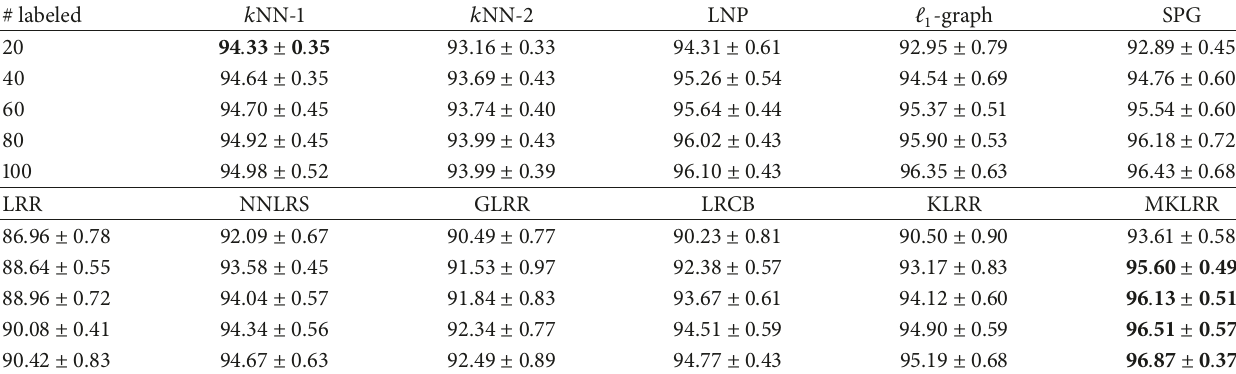
Table 5: Classification accuracies (%) of different algorithms with different number of labeled samples on the USPS data set. #